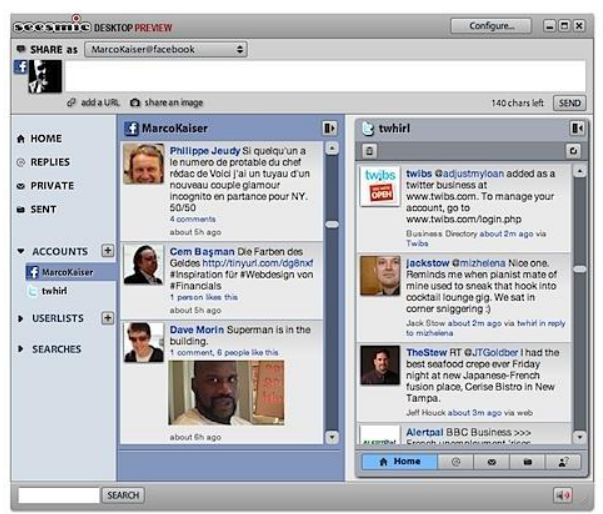
Figure 1. Seesmic Desktop